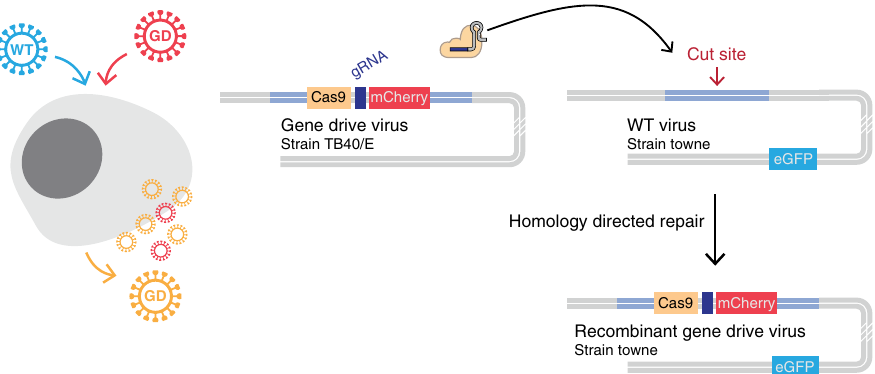
Fig. 1 Gene drive in herpesviruses. CRISPR-based gene drive sequences are, at a minimum, composed of Cas9 and a gRNA targeting the complementary wildtype (WT) locus and can harbor an additional ‘ cargo ’ that will be carried over with the rest of the sequence. When present in the same cell nucleus, Cas9 targets and cleaves the WT sequence. Homology-directed repair of the damaged WT locus using the gene drive sequence as a repair template ensures the conversion of the WT locus into a new gene drive sequence. In herpesviruses, gene drive involves the coinfection of a given cell by a WT and a modi fi ed virus. Cleavage and repair of the WT genome convert the virus into a new gene drive virus, spreading the modi fi cation into the viral population. In this example, hCMV WT virus (Towne strain) expresses eGFP fl orescent protein, and the gene drive virus (TB40/E strain) carries mCherry. Recombinant viruses then express both eGFP and